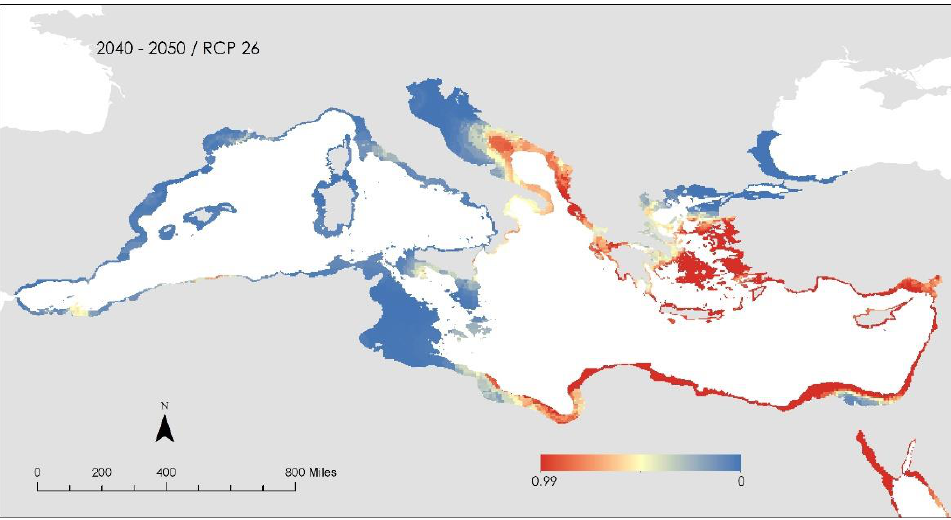
Figure 3. Lionfish potential distribution under RCP45 for the period 2040 – 2050. Figure 4. Lionfish potential distribution under RCP60 for the period 2040 – 2050.